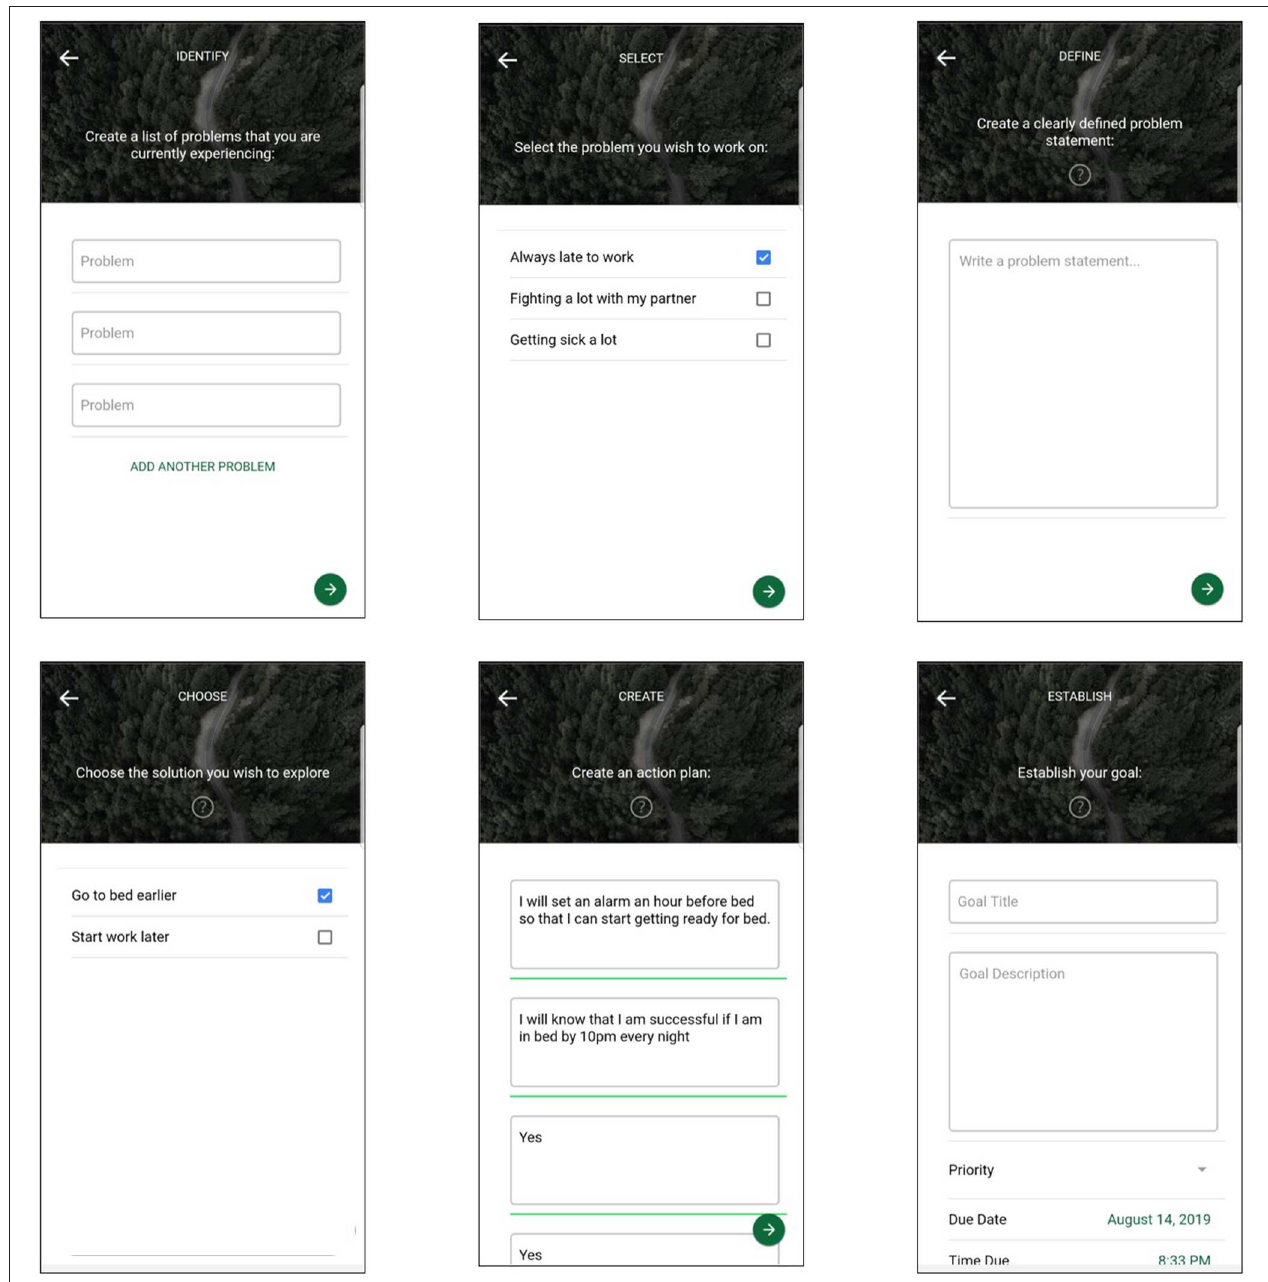
FIGURE 3 | BEACON Rx app update goal setting